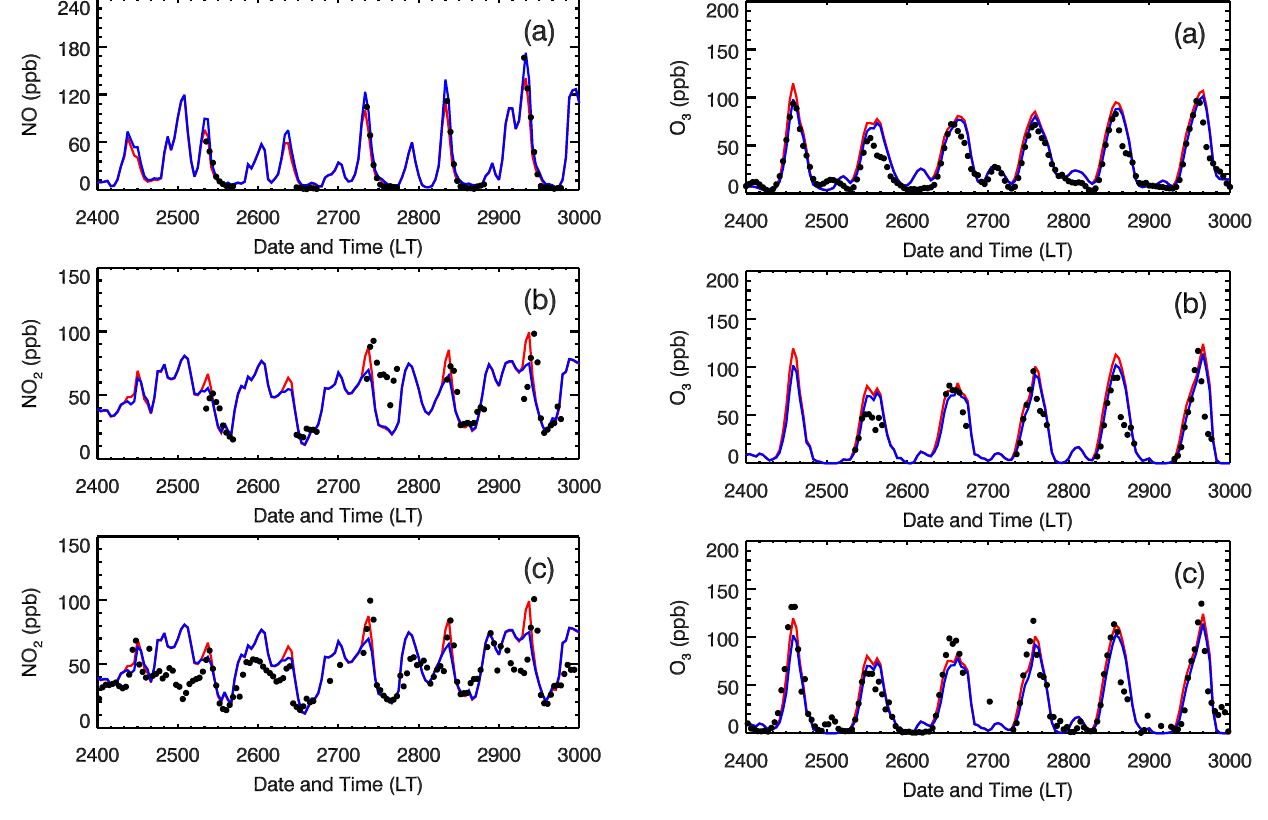
Fig. 8. Simulated and observed O 3 (a) averaged over all RAMA monitoring sites and (b) , (c) at T0 site during the 24–29 March 2006. The black dots denote the observation and the red and blue lines represent the simulations in the E-case and H-case, respec- tively. O 3 measurement in (b) is from Chemiluminescence and (c) is from